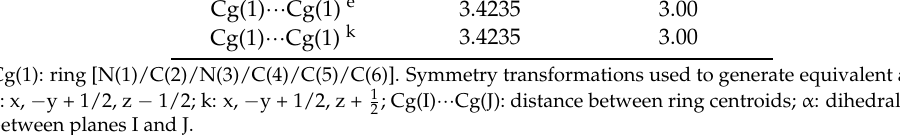
Figure A3. π , π -interactions between the six-membered rings of guanine moieties building 2D frameworks parallel to the bc plane of the crystal. Table A4. π , π -Staking interaction parameters in the crystal of compound 1 (Å, ° ).